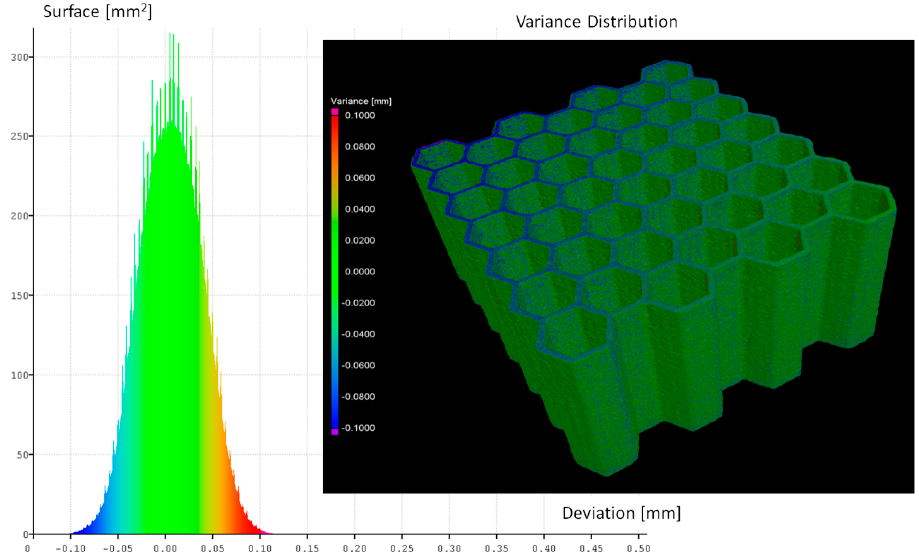
Figure 8. Geometrical quality control of specimen No. 3 before verses after heat treatment.